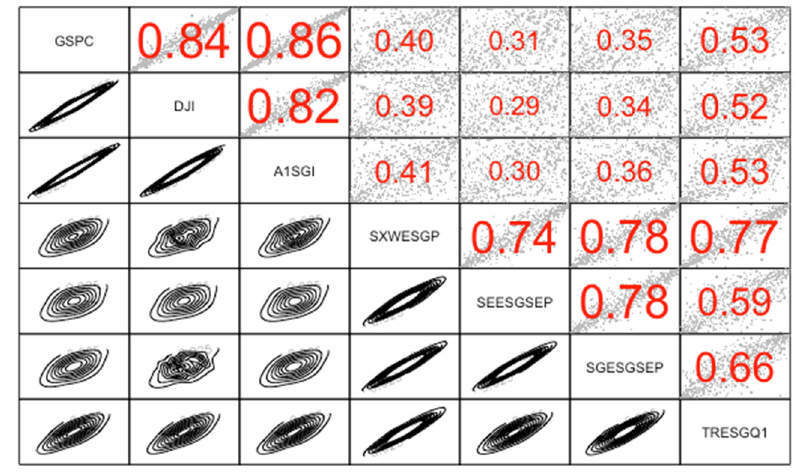
Figure 5. The rates of return, 3 June 2014–31 January 2017.